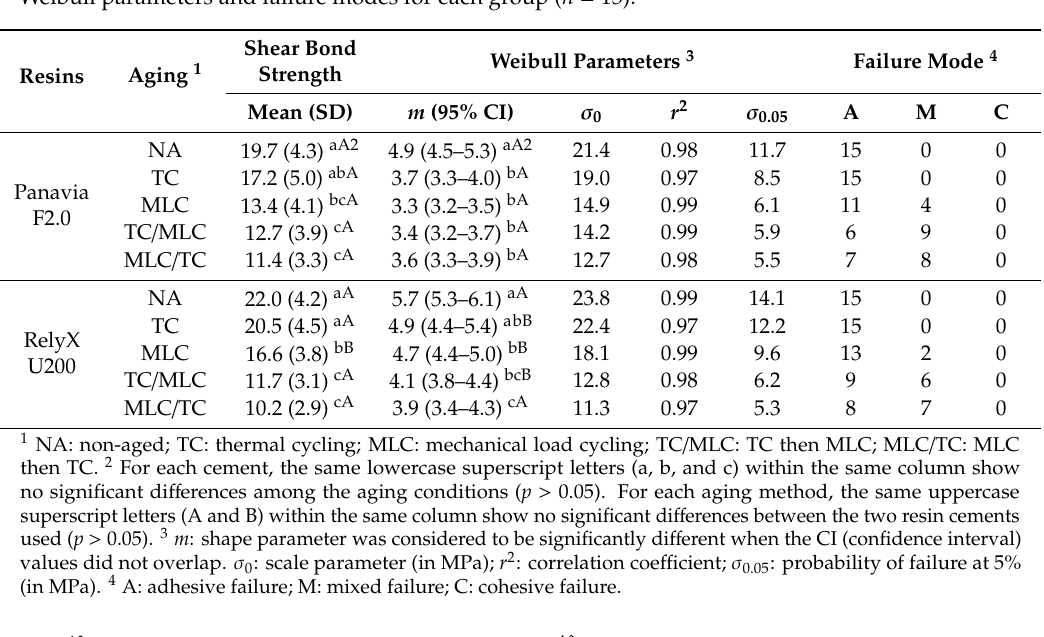
Table 3. Shear bond strength (in MPa) of the two resin cements to the zirconia surfaces, together with Weibull parameters and failure modes for each group ( n = 15).